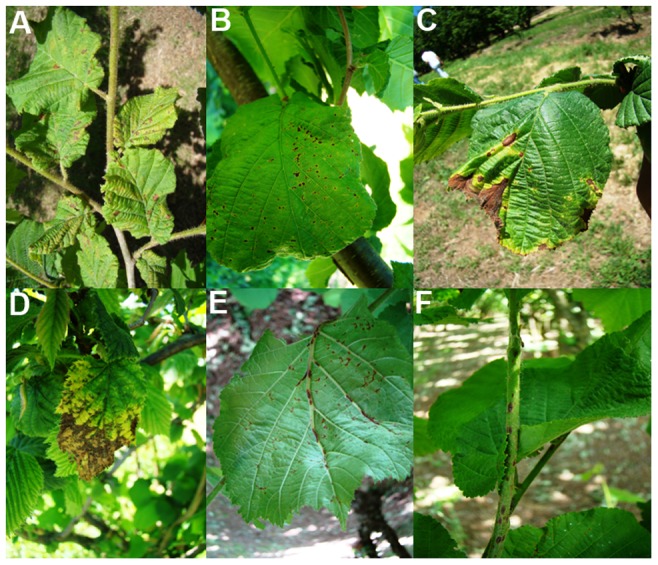
Characteristic leaf symptoms of bacterial blight observed across the hazelnut field in the spring.Water-soaked necrotic spots developed on the leaves at the beginning of the infection (A and B), the presence of extended browning area on the leaves, due to the merging of the necrotic spots, in the late stage of infection (C and D), presence of longitudinal necrosis on the mid-ribs and secondary veins of the lower leaf surface (E) and on young stem (F).